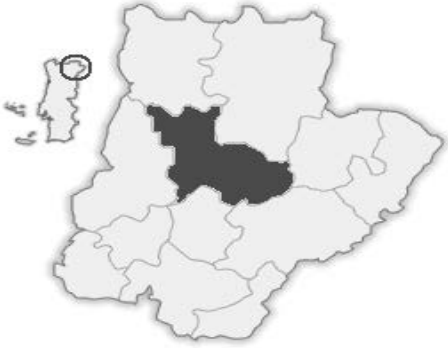
Figure 5. “Terra Quente” region, in which the DOP honey samples were